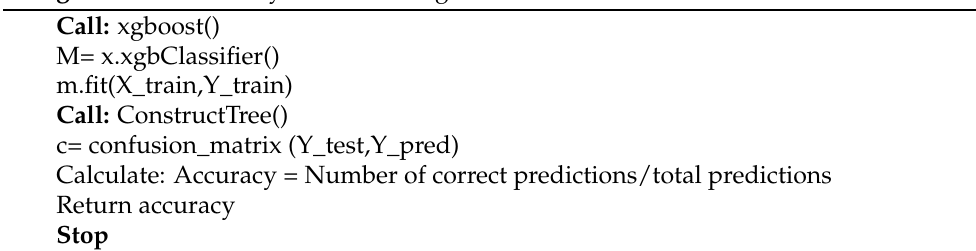
Algorithm 2: Accuracy Prediction Algorithm